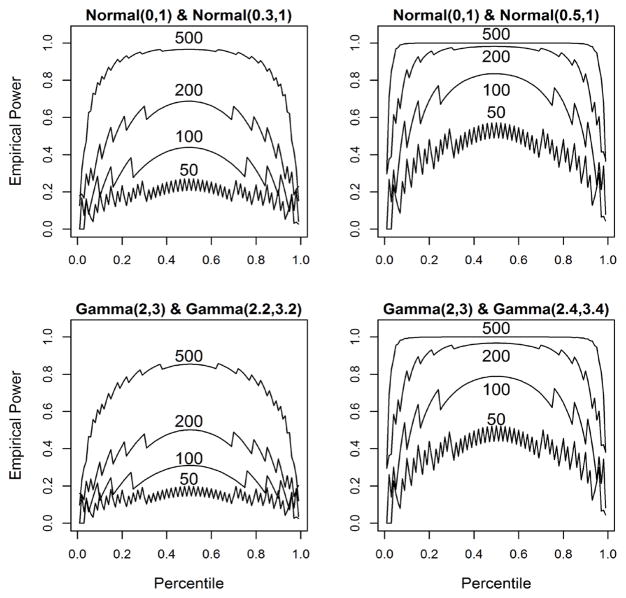
Power Simulations of testing a single percentile from 0.01 to 0.99 in 0.01 increments for normal and gamma distributions for n = 50, 100, 200, 500.